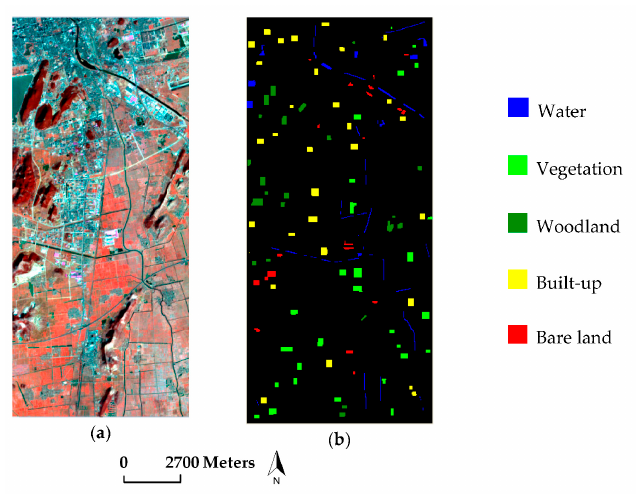
Figure 3. ( a ) False color composite of Bands 84 (983.08 nm), 33 (681.20 nm) and 26 (609.97 nm); and ( b ) true ground map (Xuzhou dataset).